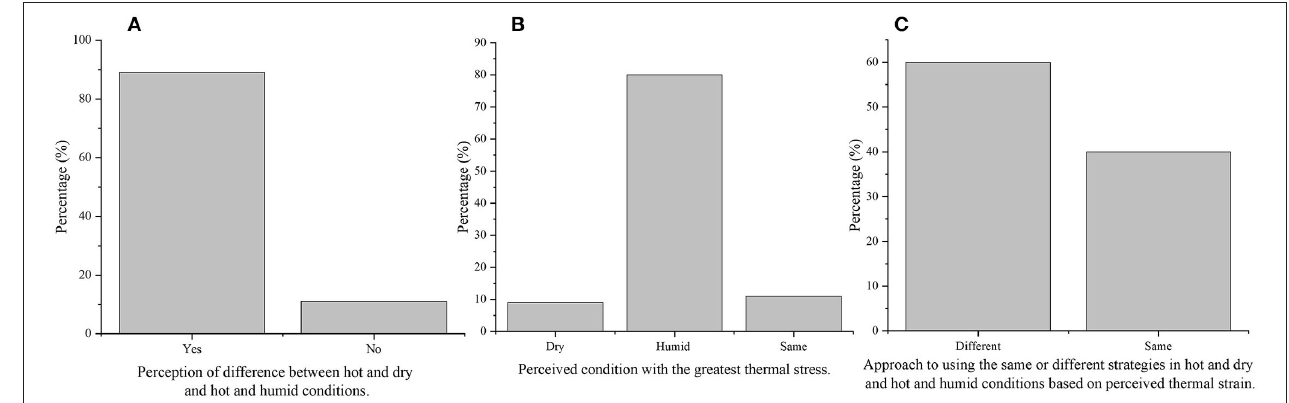
FIGURE 2 | (A) Perceived difference between hot and dry and hot and humid conditions, (B) perceived condition with the greatest thermal stress, and (C) approach to using the same or different strategies in hot and dry and hot and humid conditions based off perceived thermal strain.